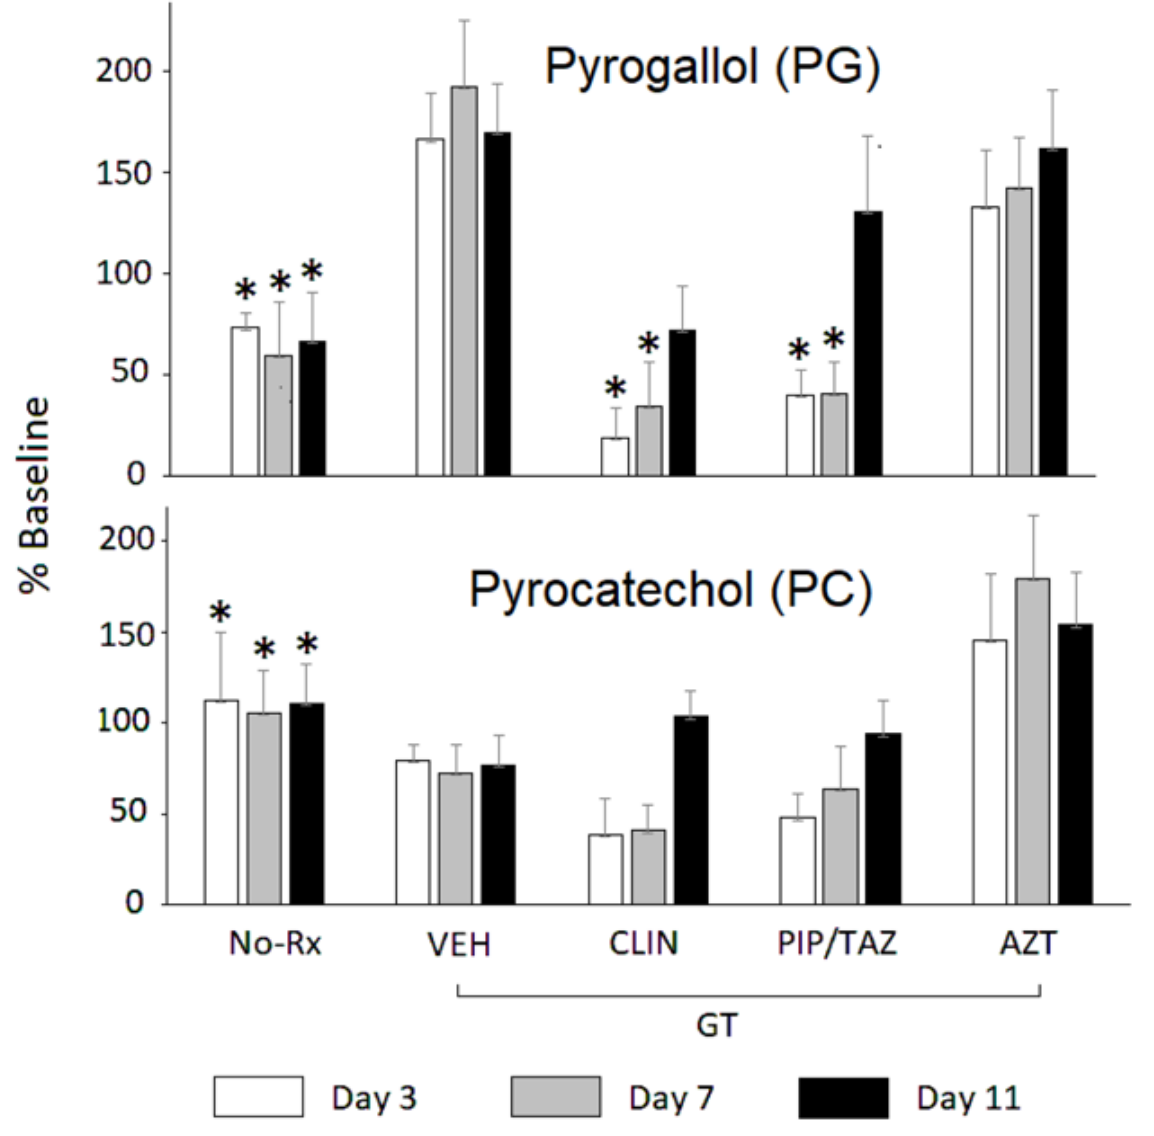
Figure 2. One group of mice (No-Rx) did not receive either green tea (GT) or antibiotics. Of the remain- ing groups, all received GT in drinking water continuously and in addition either a saline vehicle (VEH), clindamycin (CLIN), piperacillin/tazobactam (PIP/TAZ), or aztreonam (AZT) SC on days 1–2. Data are presented as a percent of the baseline (day 0) for the given group. Statistical analyses were conducted on the absolute levels. Mean + SEM. *significantly different from VEH (ie, GT only) for the corresponding day, corrected for multiple